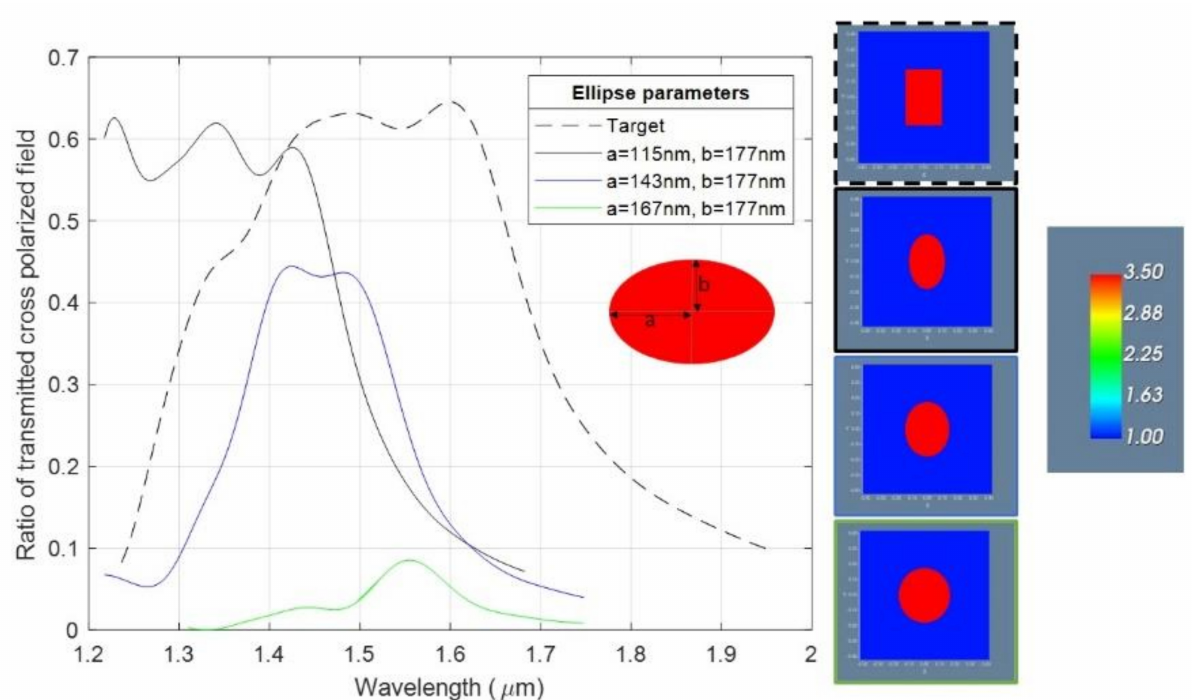
Figure 11. Plots of ellipse simulation curves, with different values for the a and b parameters based on metalenses patterns dimensions found from SEM images.